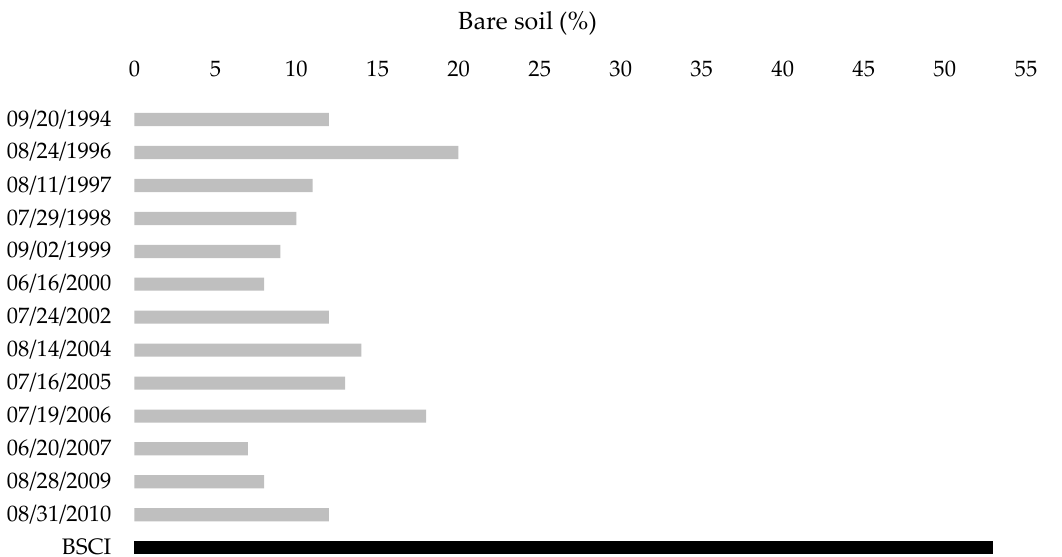
Figure 6. Percentage of bare soil occurrences from the satellite images and the Bare Soil Composite Image (BSCI), which represents total bare soil for the entire area of 242,000 hectares.